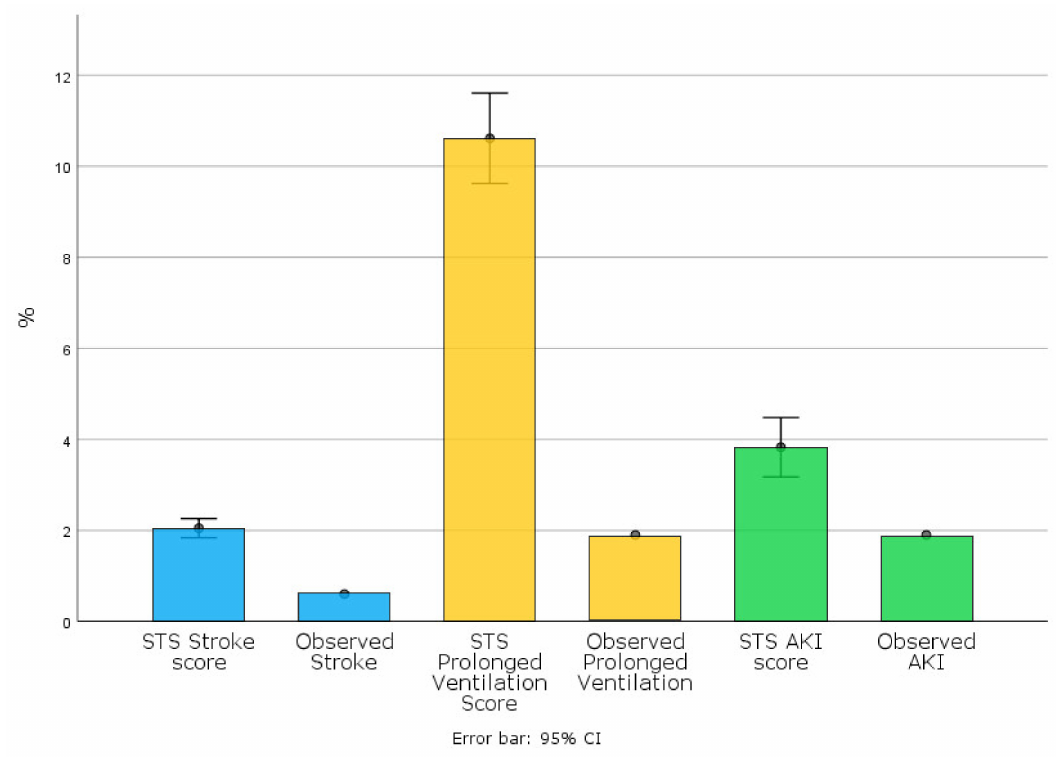
Figure 3. Expected and observed periprocedural